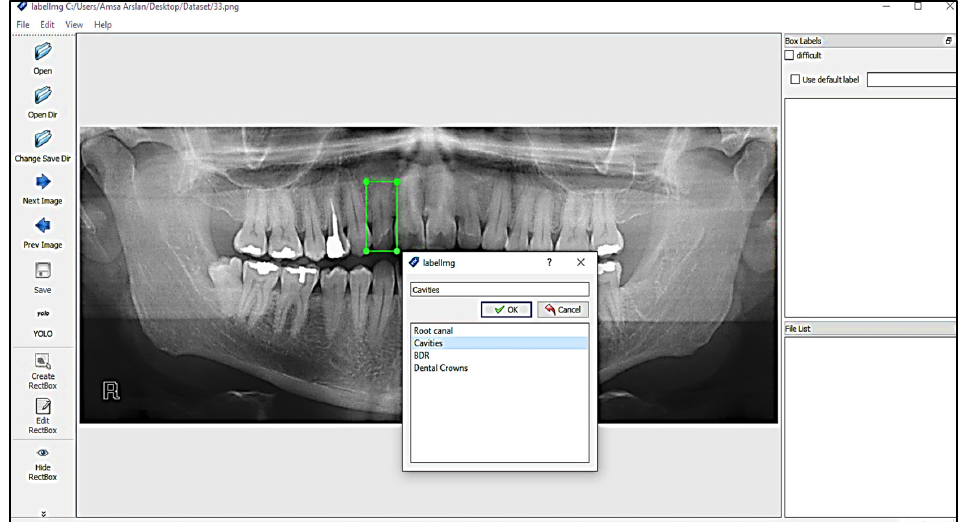
Figure 4. Labeling process with LabelImg.